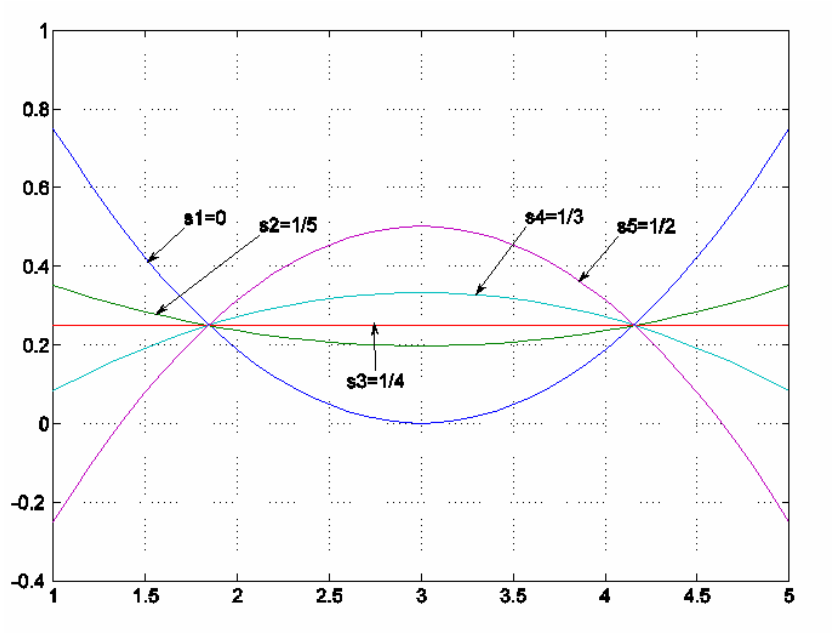
Fig. 5. Slope changes for various cubic utility functions along the assessment scale x